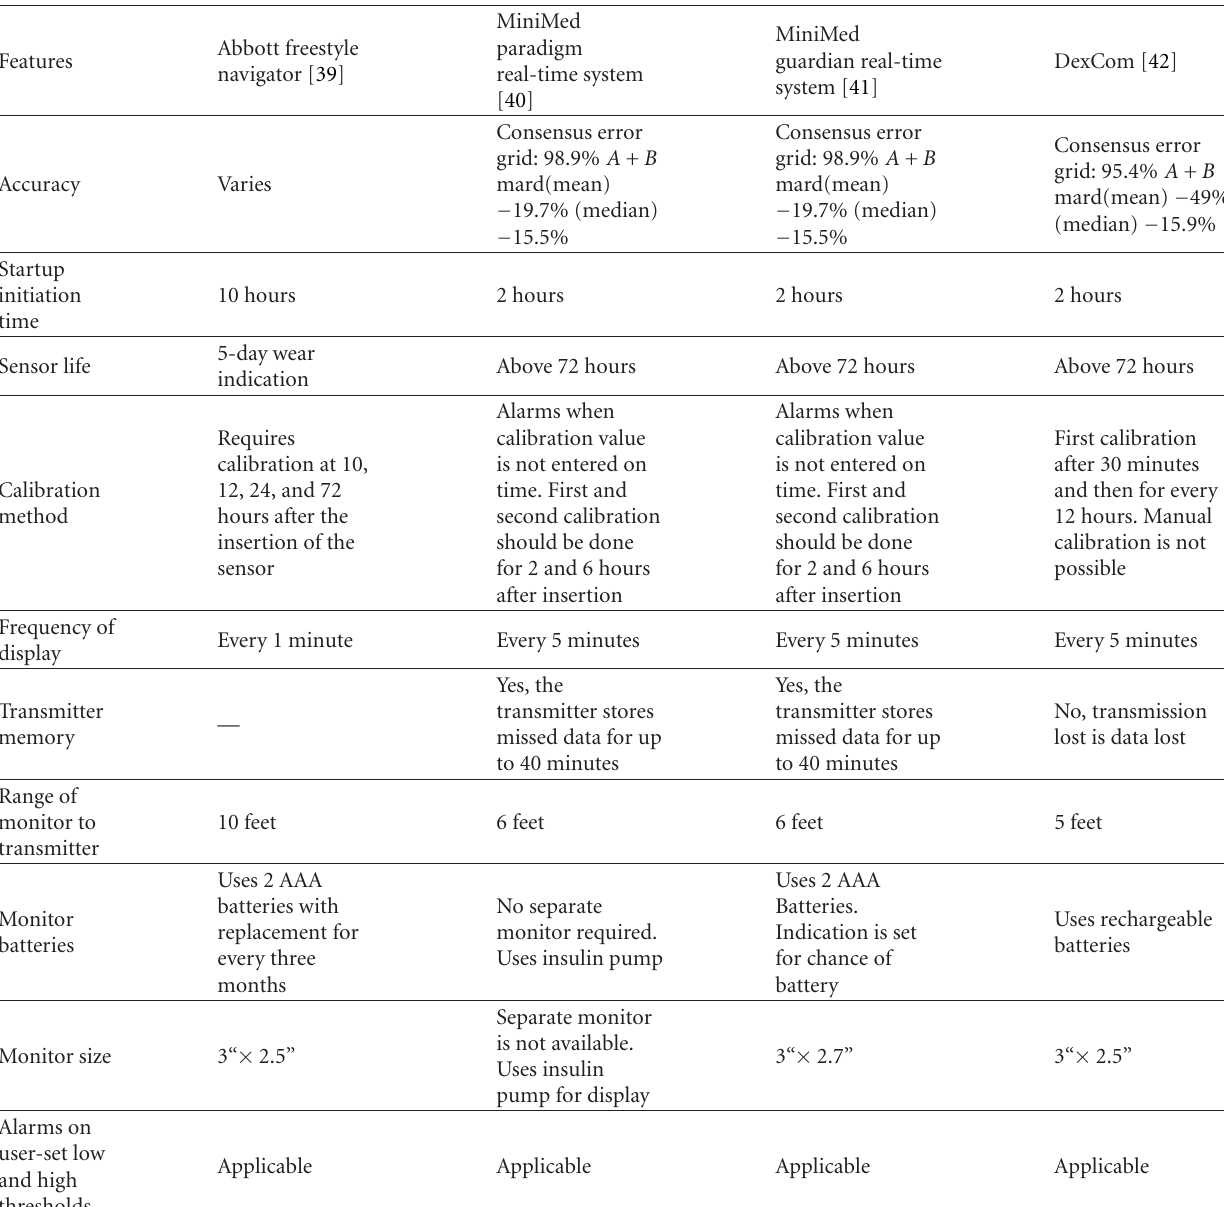
Table 2: Specification comparison of commercial blood glucose